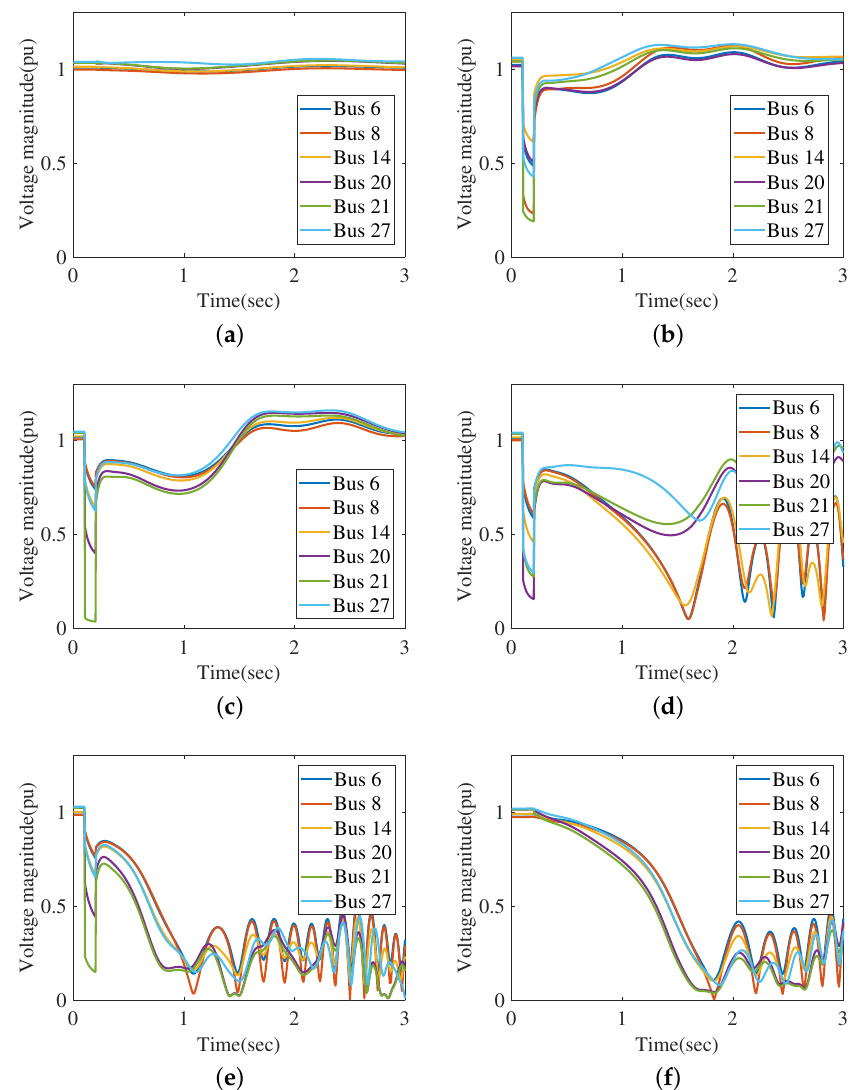
Figure 2. Time domain voltage simulation at various buses for defined scenarios: ( a ) Case a, ( b ) Case b, ( c ) Case c, ( d ) Case d, ( e ) Case e, ( f ) Case